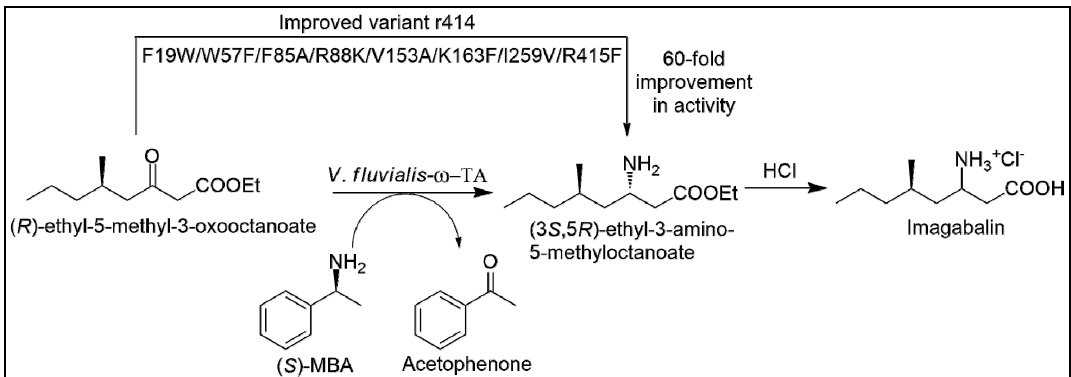
Figure 5. Improved production of Imagablin by protein engineering of ( S )- ω -TA Vf [71]. (Reaction conditions: 4.0 g of wet E. coli cells containing ( S )- ω -TA Vf mutant r414, 88 mL potassium phosphate buffer (0.1 M, pH 7.0); 54 mg pyridoxal phosphate; 1 g substrate, 7.5 mL of 1 M solution of ( S )- α -MBA, 30 °C, 24 h).